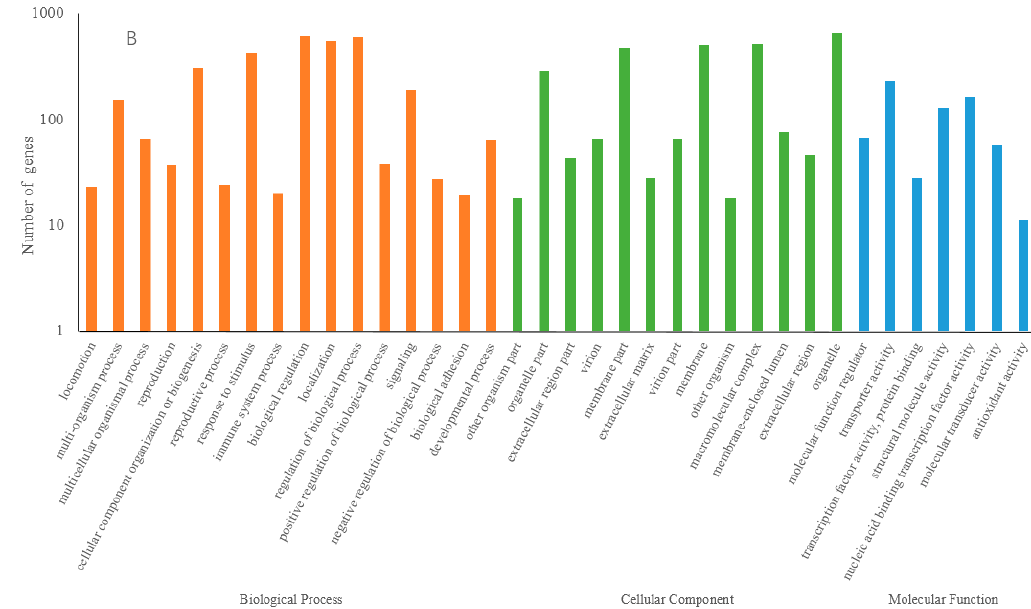
Figure 4. Functional analysis of differentially expressed lncRNA in drought stress. ( A ) Gene ontology (GO) analysis of putative target genes of differentially expressed lncRNA of 24 h vs. 0 h; ( B ) GO analysis of putative target genes of differentially expressed lncRNA of 48 h vs. 0 h. GO analysis contains three branches: biological process (orange), cellular component (green) and molecular function (blue). 0 h, 24 h and 48 h indicate that the samples were treated under drought stress for 0 h, 24 h and 48 h, respectively.